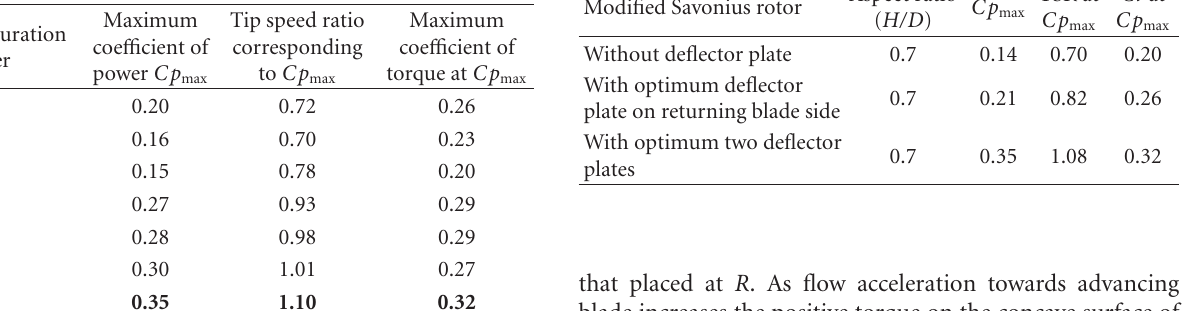
Table 3: Maximum coe ffi cient of power and the corresponding tip speed ratio and coe ffi cient of torque for the configuration studied on the two deflector plates.